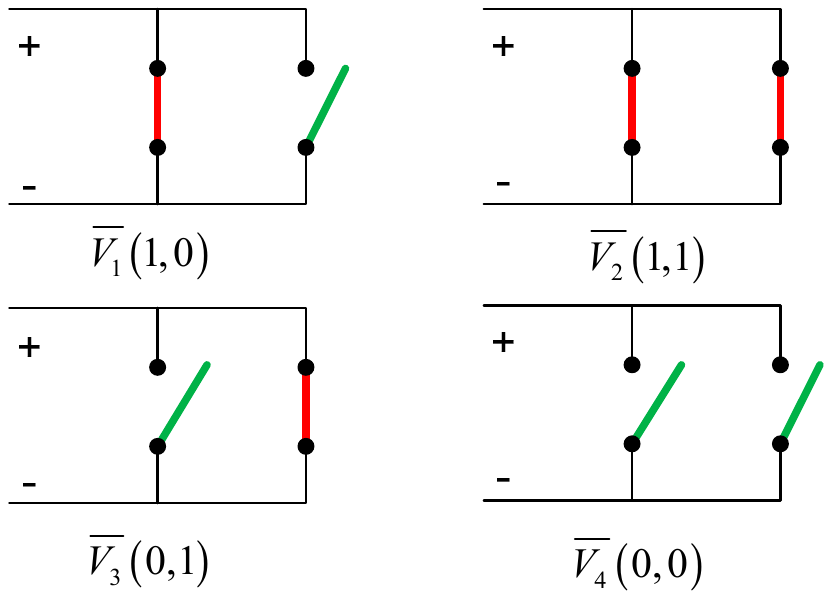
Figure 2. Two-phase inverter switching states.